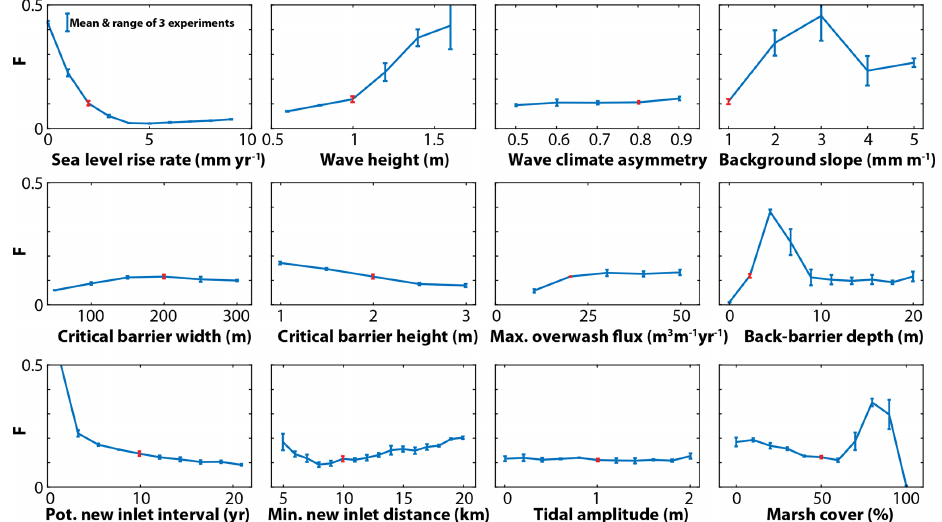
Figure 11. Fraction F for varying model parameters showing the mean and the range obtained for three different experiments. In red is the value of the specific parameter that is held constant across the other